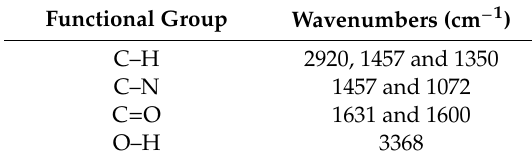
Table 1. The analysis of the FT-IR spectra results of BS-12.